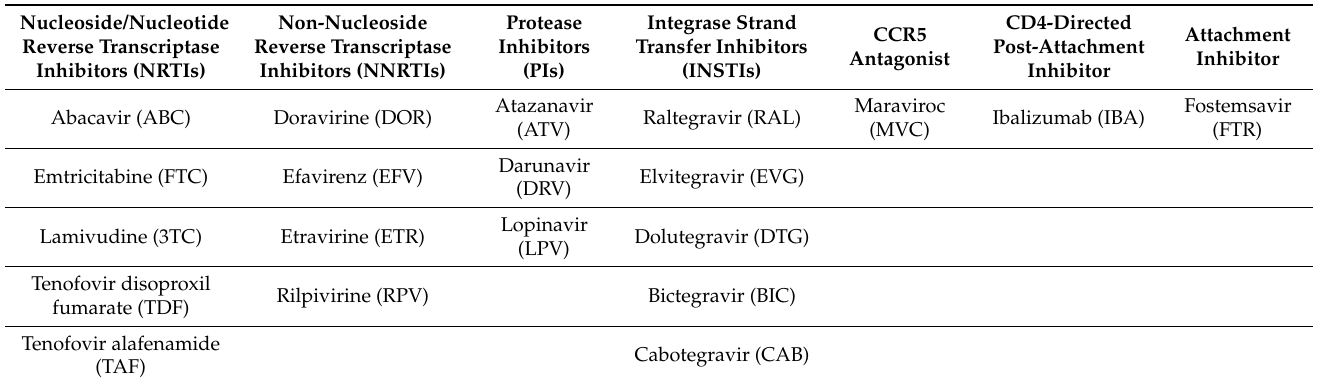
Table 1. Antiretroviral agents (by mechanism of action) used in contemporary management of HIV.